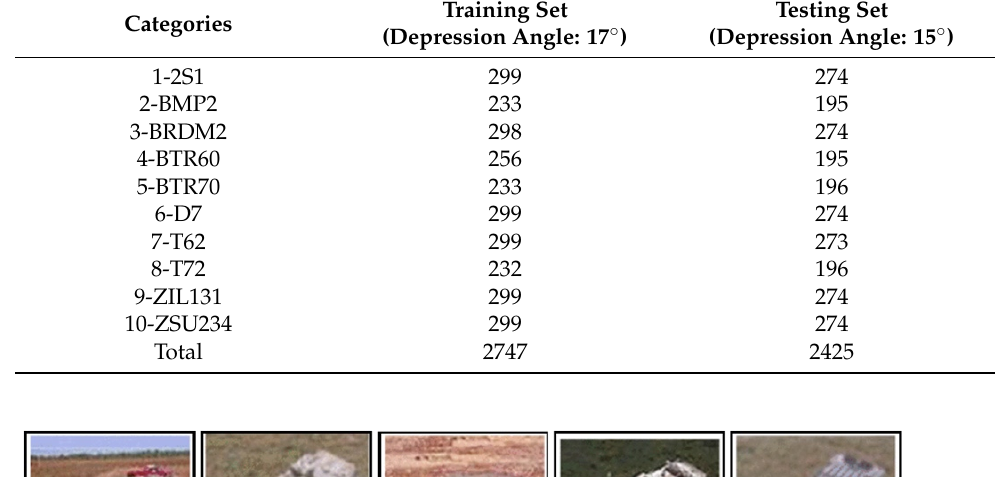
Table 2. MSTAR 10 types of dataset.